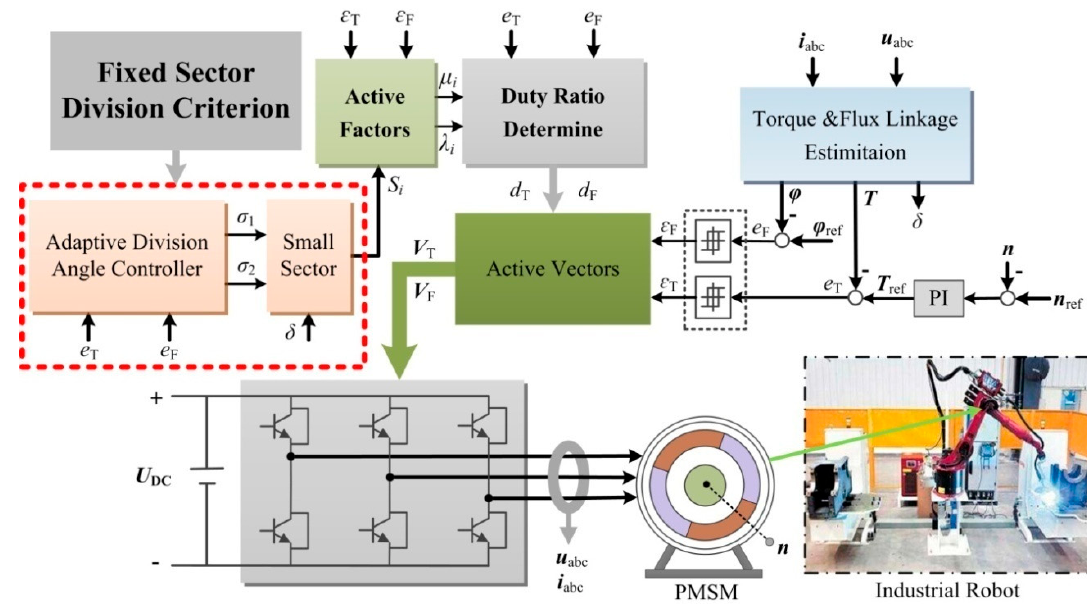
Figure 1. Schematic diagram of the novel direct torque control (NDTC) strategy for a permanent magnet synchronous motor (PMSM). Reproduced/Adapted with permission from [2], T, Q, Yuan, IEEE Access, T, Q, Yuan, 2019"